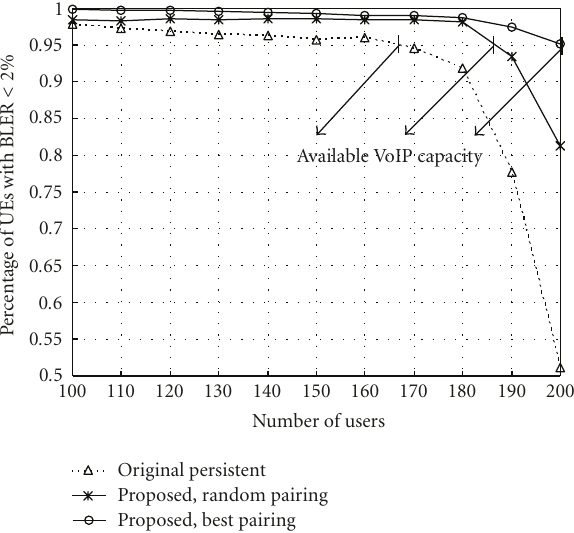
Figure 5: Outage probability versus number of VoIP users.